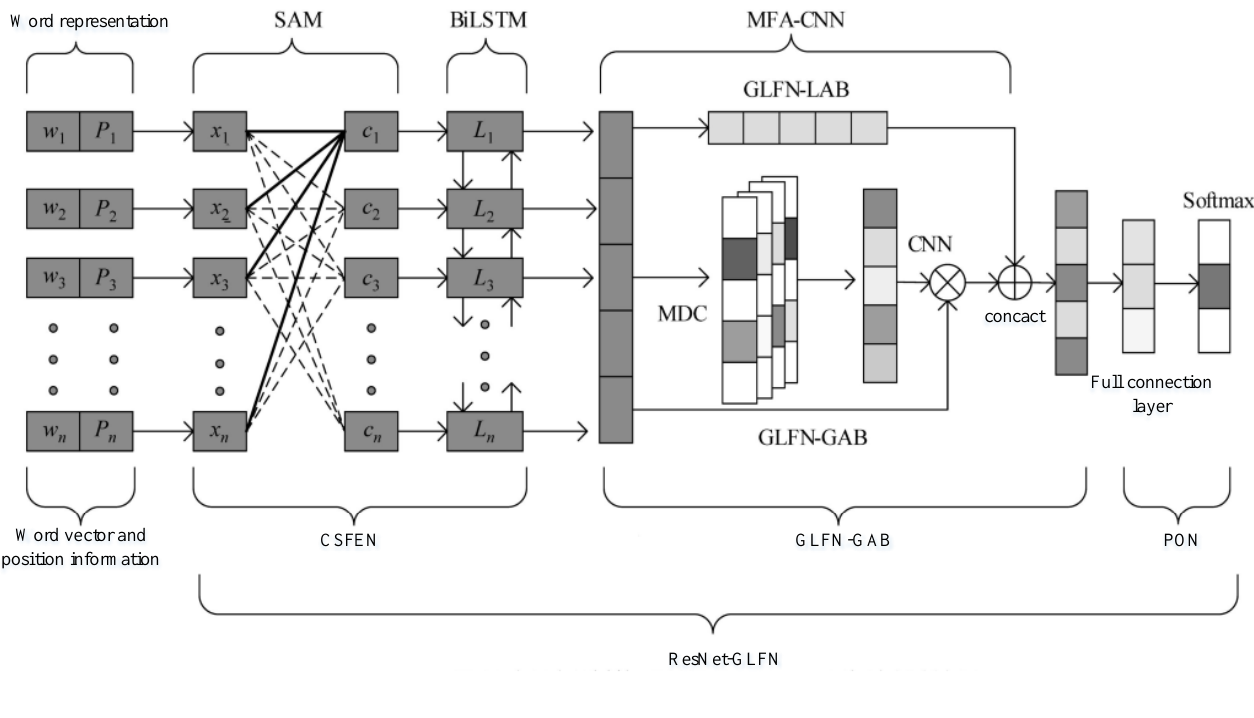
Figure 2. ResNet-GLFN network